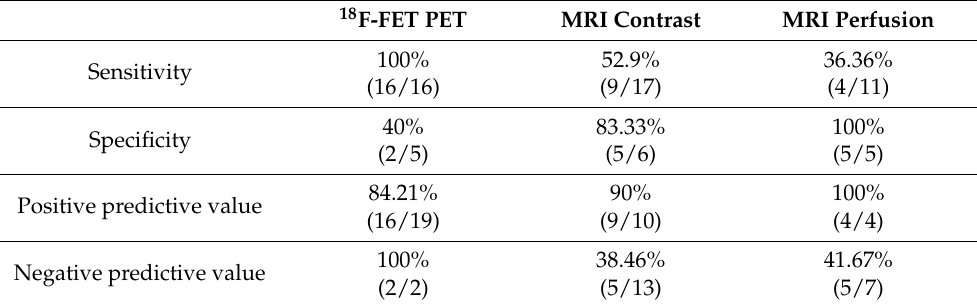
Table 2. Diagnostic performance of each modality at initial diagnosis regarding histological analysis. 18 F-FET PET MRI Contrast MRI Perfusion